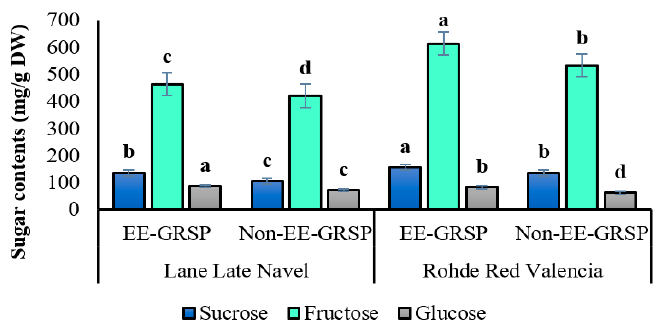
Figure 2. Effects of exogenous, easily extractable glomalin-related soil protein (EE-GRSP) on sucrose, fructose, and glucose concentrations in fruits of Lane Late Navel (LW) and Rohde Red Valencia (XC) varieties of sweet orange. Data (means ± SD, n = 5) followed by different letters at the bar indicate significant differences ( p < 0.05) among treatments.